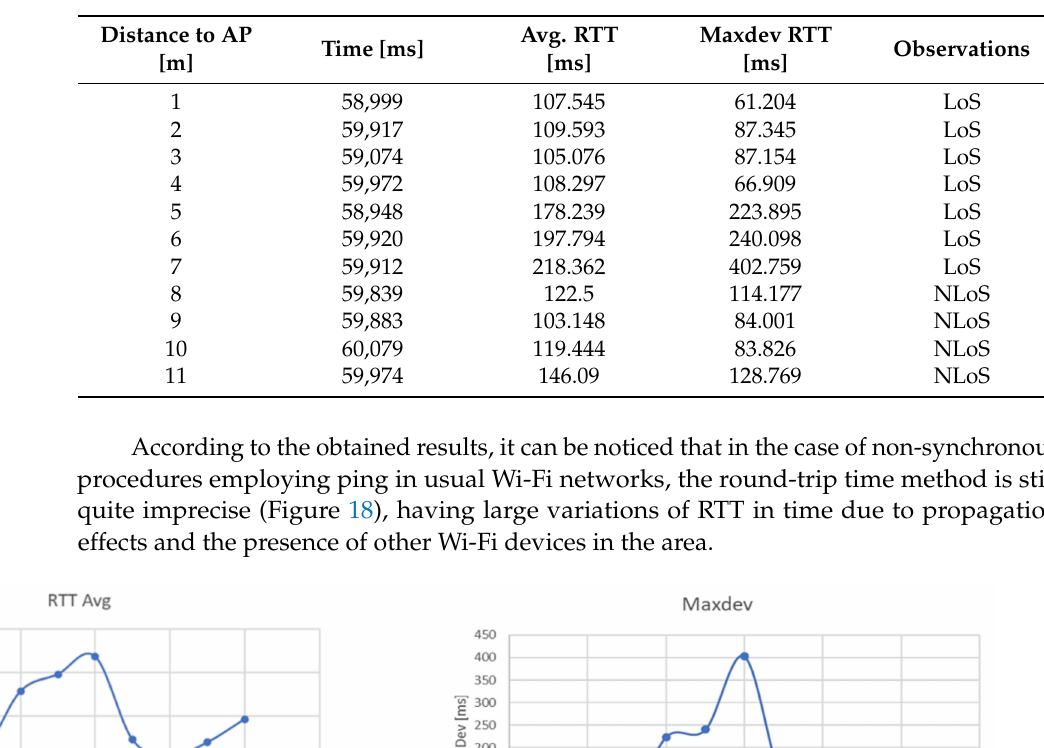
Table 6. Recorded values during RTT measurements.